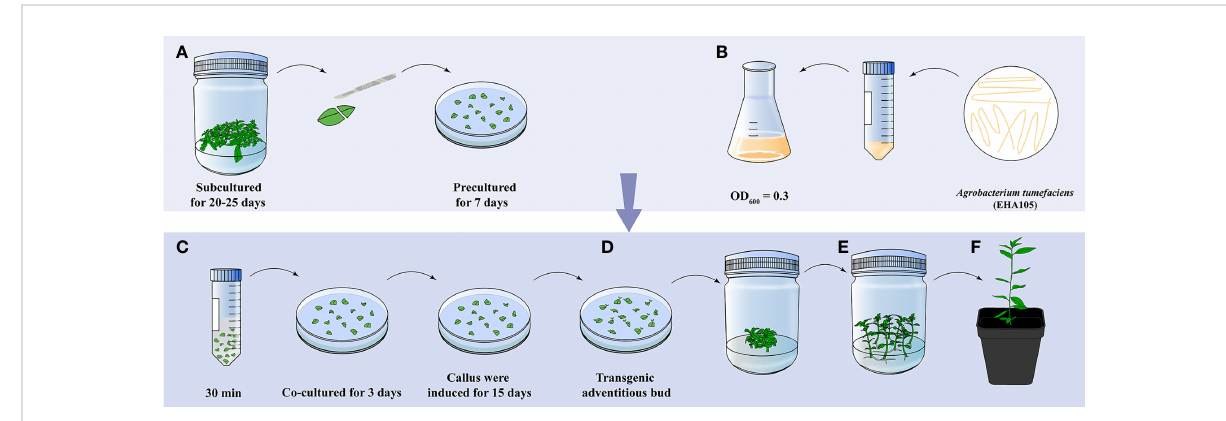
FIGURE 8 Agrobacterium -mediated E. urophylla × E. grandis DH32-29 leaf transformation work fl ow. (A) Leaves were cut from plantlets that were subcultured for 20 – 25 days and precultured in callus-inducing medium for 7 days. (B) Agrobacterium EHA105 was cultured to 0.3 (OD 600 ) and (C) infected leaves for 30 min. Leaves were cocultured for 72 h and transferred to callus-inducing medium to induce calluses. (D) Transgenic adventitious buds were generated when explants were cultured in shoot-inducing medium. (E) Transgenic buds were propagated, induced roots, and (F) planted in the soil.